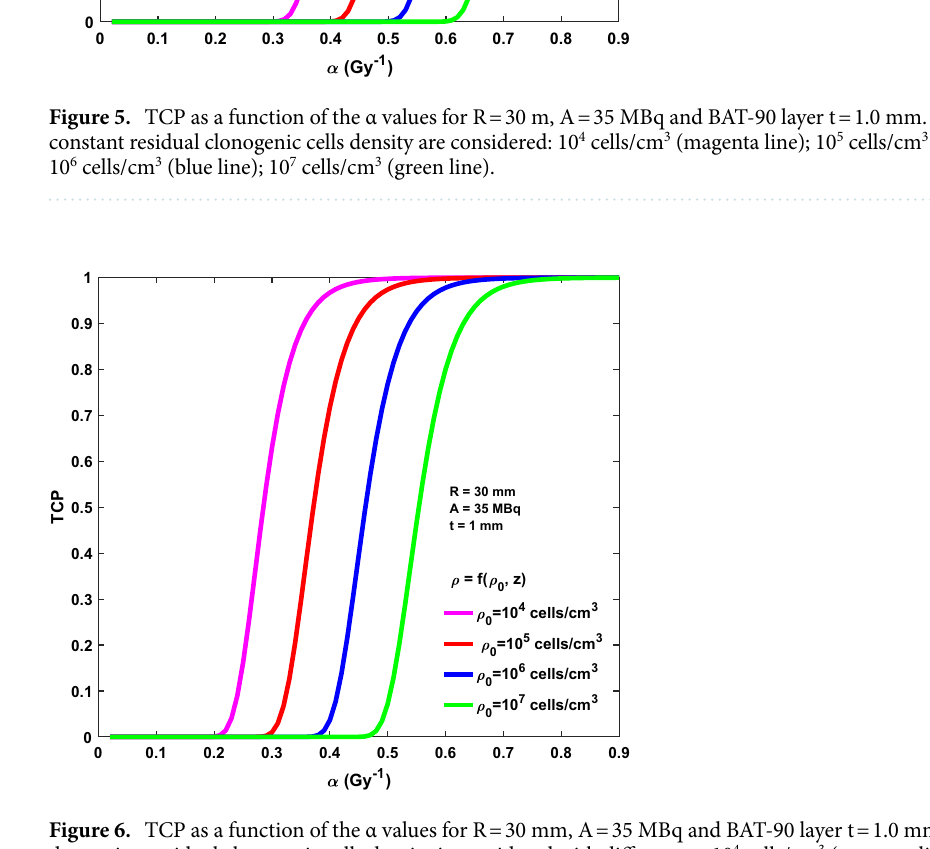
Figure 6. TCP as a function of the α values for R = 30 mm, A = 35 MBq and BAT-90 layer t = 1.0 mm. A linearly decreasing residual clonogenic cells density is considered with different ρ 0 : 10 4 cells/cm 3 (magenta line); 10 5 cells/cm 3 (red line); 10 6 cells/cm 3 (blue line); 10 7 cells/cm 3 (green